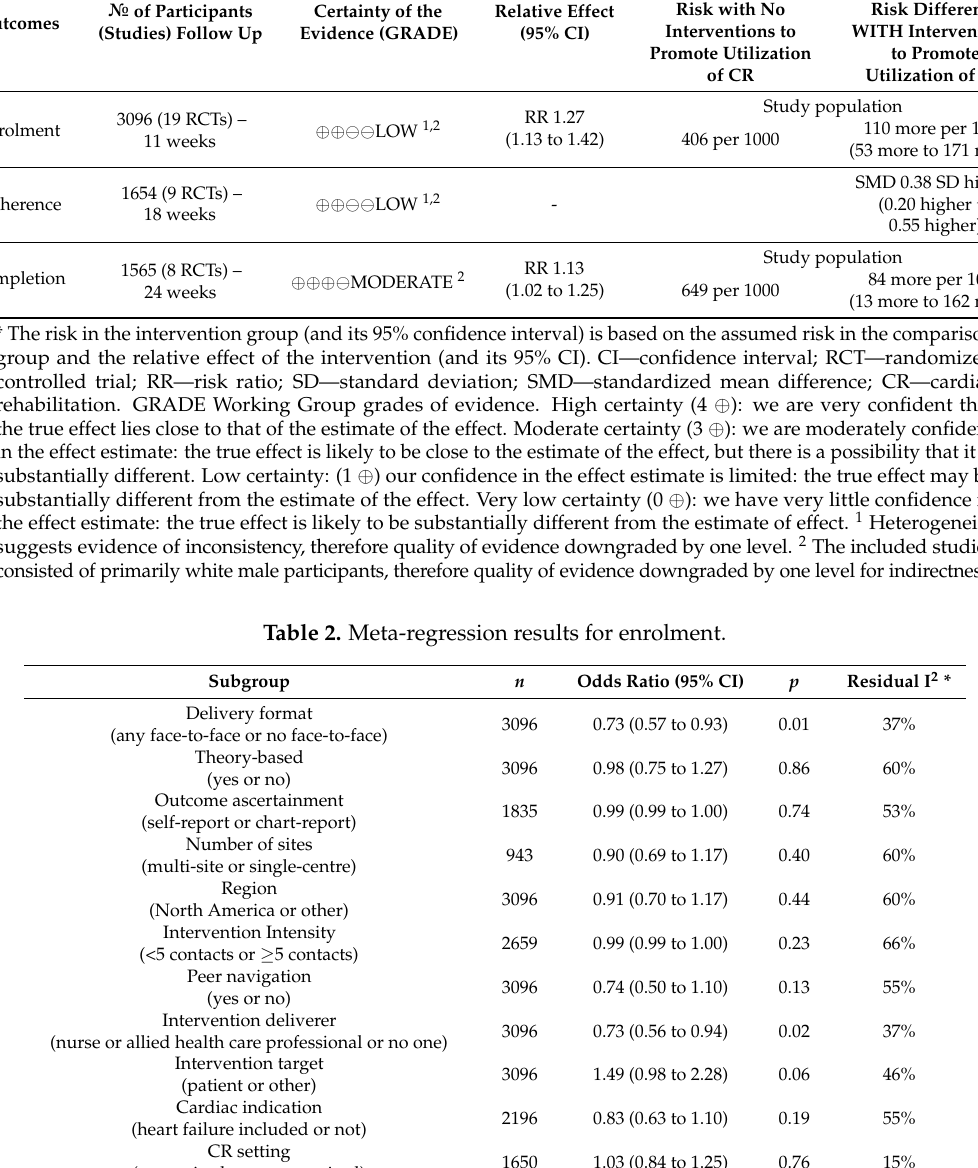
Figure 2. The risk of bias in included trials. Note: Review authors’ judgments about each risk of bias element are presented as percentages across all included trials.